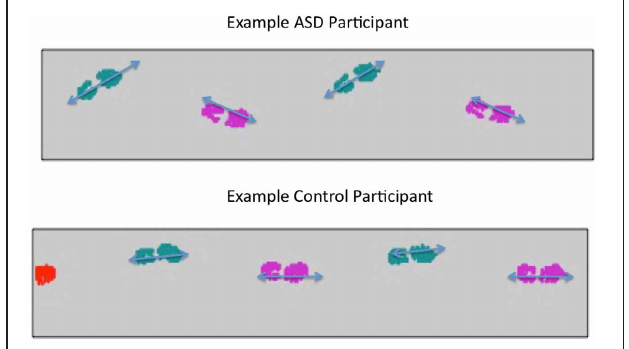
FIGURE 1 | Example of foot positioning of ASD and Control Group participants.